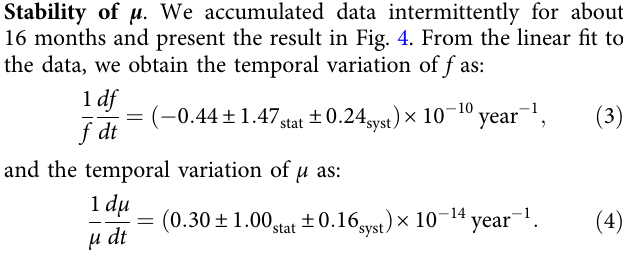
and | N = 1 〉 , whose sensitivity to the electric fi eld (~12.4 Hz cm 2 V − 2 ) is one order higher than that of the |i 〉 − |f 〉 transition (~1.08 Hz cm 2 V − 2 ). However, a fi nite residual electric fi eld of